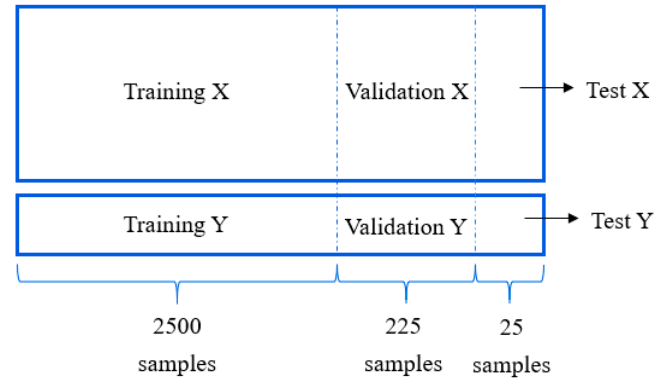
Figure 5. Data partition including training set, validation set, and test set.